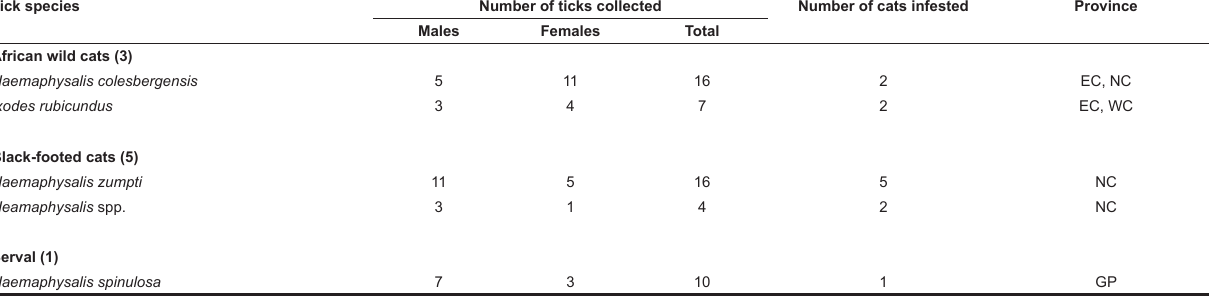
TABLE 4 Ticks collected from 3 African wild cats, 5 black-footed cats and a serval in four of South Africa’s nine provinces Tick species Number of ticks collected Number of cats infested Province Males Females